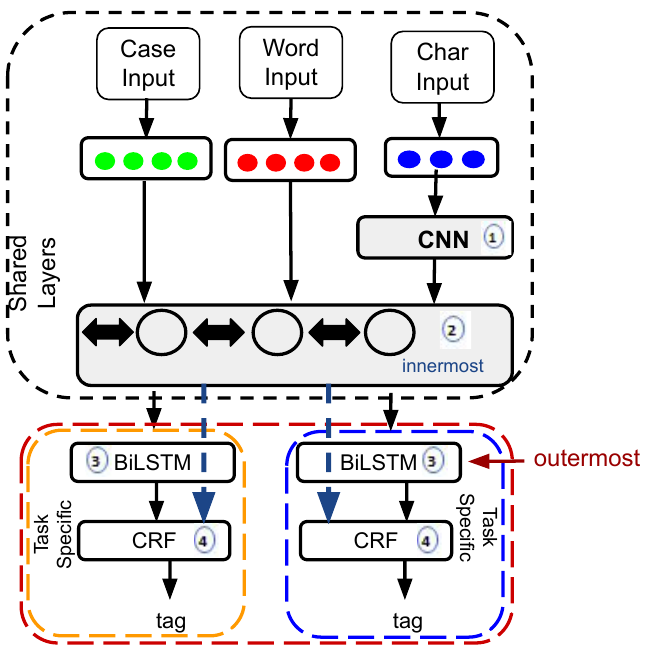
Figure 3. The proposed MTM-CNN (circles represent embeddings). Innermost indicates the task is trained without task-specific BiLSTM. Outermost indicates the task is trained with task-specific BiLSTM. Differently from Wang et al. [35], the proposed MTM-CNN utilizes a CNN (repre- sented by the circled 1 in Figure 3) instead of BiLSTM, to extract character-level